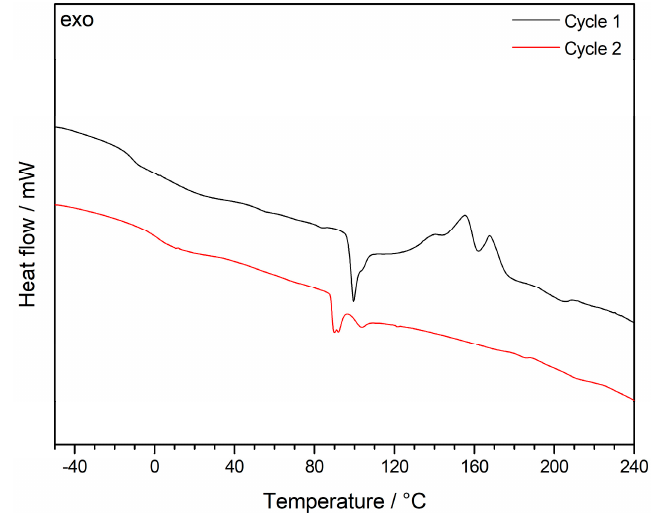
Figure 4. Differential Scanning Calorimetry (DSC) thermograms of PS- co -PALMA@P(EA- co -MPSEt) lyophilized particle powder with a heating rate of 5 K min − 1 under nitrogen atmosphere.